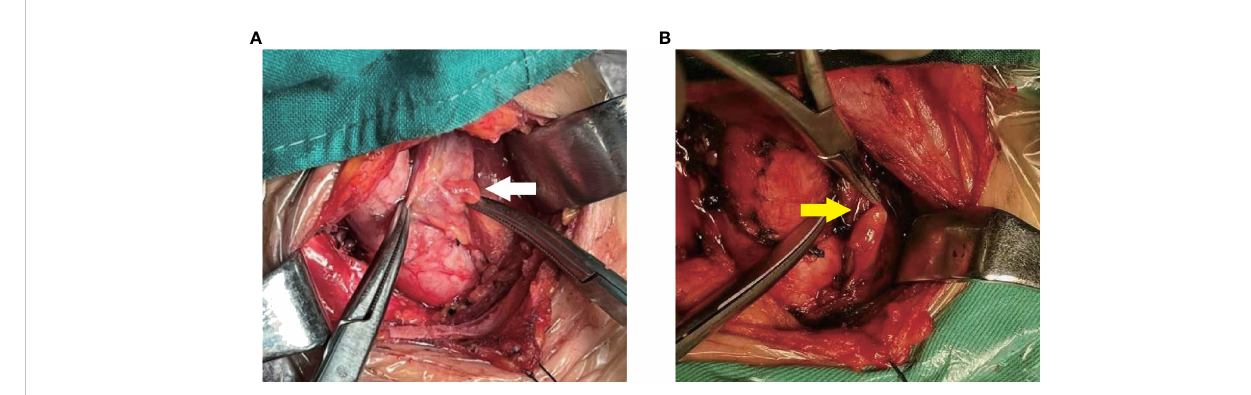
FIGURE 7 Two types of IPG observed during surgery. (A) : White arrow shows Type I PG; (B) : yellow arrow shows Type II